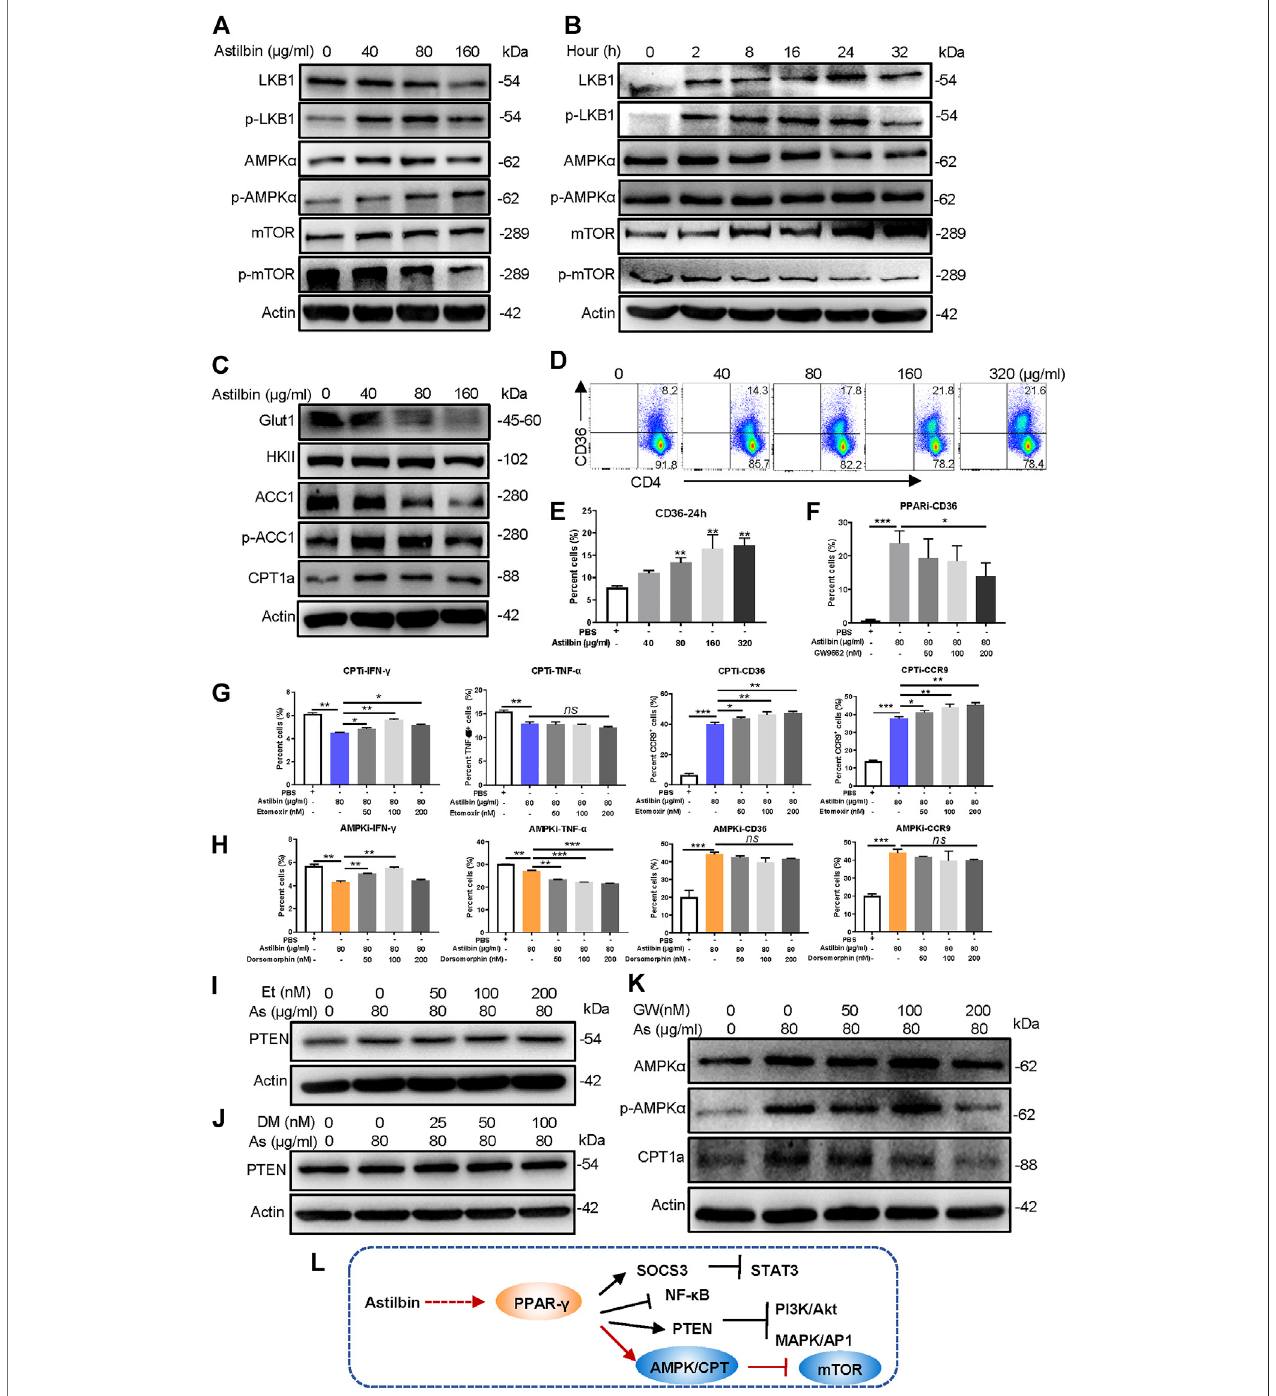
FIGURE 4 | PPAR γ /AMPK pathway in astilbin-treated CD4 + T cells. Variations of LKB1/p-LKB1, AMPK/p-AMPK, and mTOR/p-mTOR in CD4 + T cells treated with various doses of astilbin (A) or at different time points (B) . (C) Variations of proteins involved in glucose and lipid metabolism. CD36 of CD4 + T cells affected by astilbin (D, E) . Mean ± SD; n = 3. (F) Effects of PPAR γ inhibition on CD36 expression. Mean ± SD; n = 3. Effects of CPT inhibition (etomoxir) (G) or AMPK inhibition (dorsomorphin) (H) on IFN- γ , TNF- α , CD36, and CCR9 of astilbin-treated CD4 + T cells. Mean ± SD; n = 3. Effects of etomoxir (I) or dorsomorphin (J) on PTEN expression of astilbin-treated CD4 + T cells. (K) Effects of PPAR γ inhibition on AMPK and CPT1a expression of astilbin-treated CD4 + T cells. (L) Diagram of PPAR/PTEN pathway on CD4 + T cells by astilbin. Each experiment was performed at least three times. The inhibitor of CPT, etomoxir, is abbreviated as CPTi. The inhibitor of AMPK, dorsomorphin, is abbreviated as AMPKi. p values (* p ≤ 0.05; ** p ≤ 0.01; *** p ≤ 0.001; ns, no signi fi cant difference) determined by one-way ANOVA (E – H) .